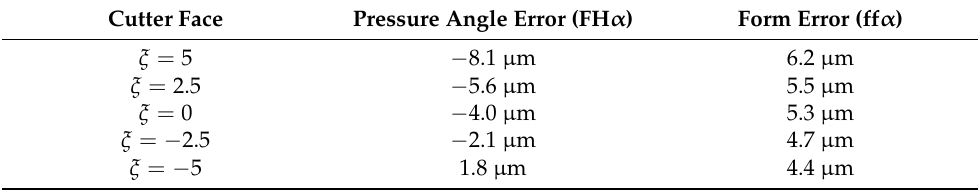
Table 2. Cutter edge profile error of the original case corresponding to the cutter faces. Cutter Face